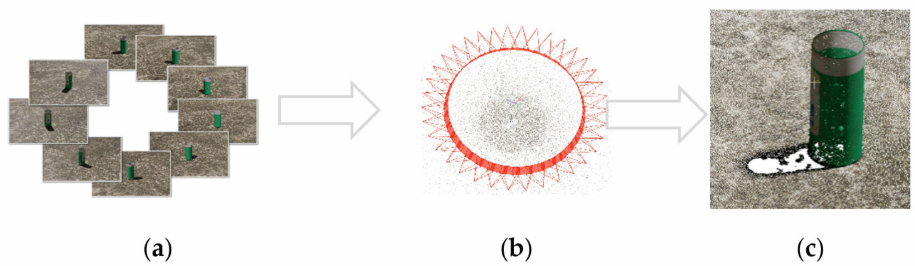
Figure 4. ( a ) Input to Colmap: multi-view 2D images; ( b ) 3D point cloud reconstruction from multi-view 2D images; ( c ) reconstructed 3D point